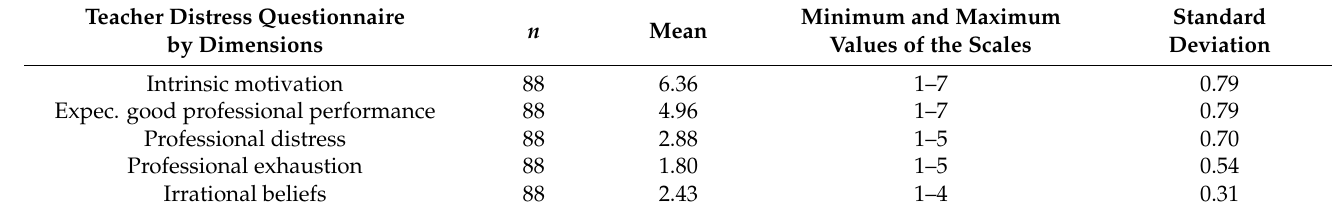
Table A1. Means and standard deviations of the Teacher Distress Questionnaire scale by dimensions, meaning maximum and minimum values of the subscales. Source: own